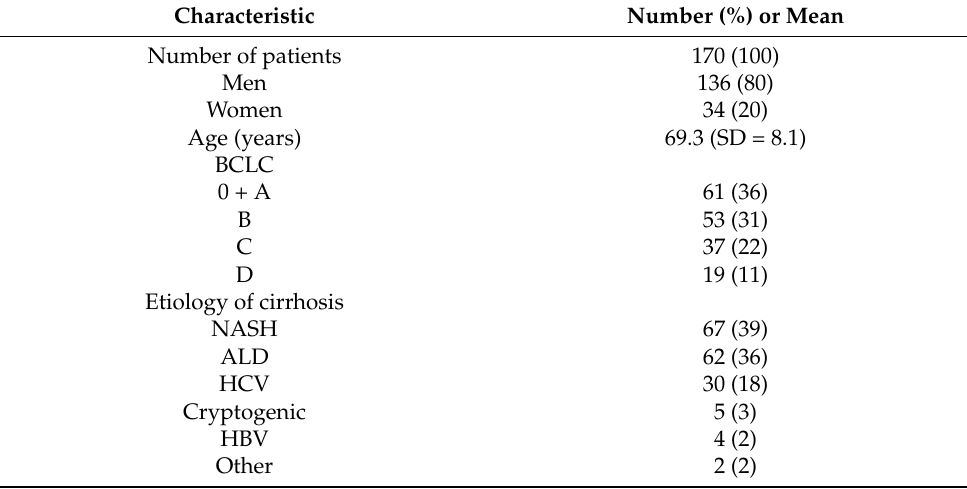
Table 2. Characteristics of the